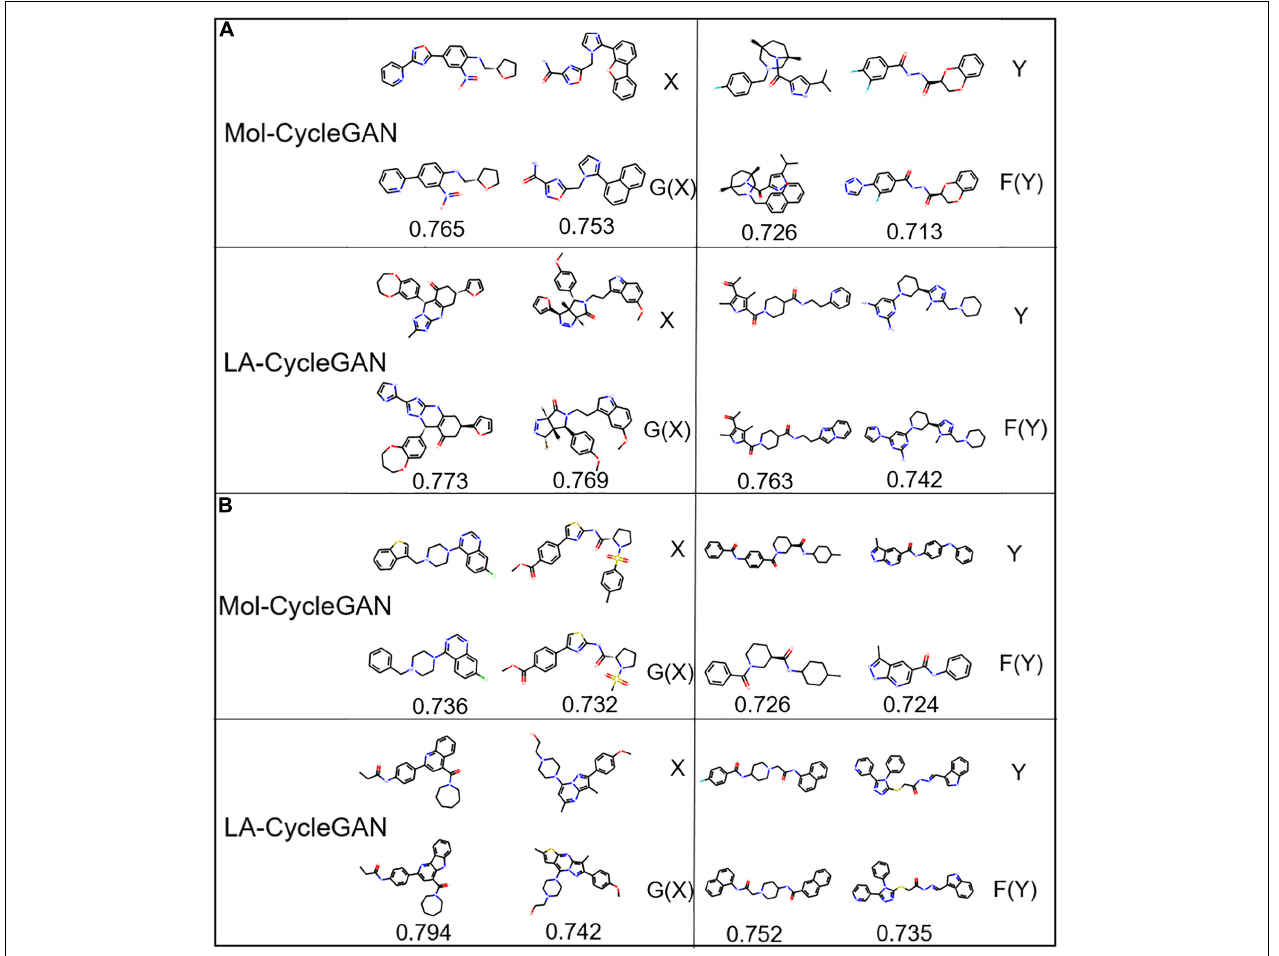
FIGURE 8 | Molecular structure diagram. (A) Molecules from the HBA subset; (B) molecules from HBD subset. In each sub-figure, the upper layer shows the starting molecules, the middle layer shows the generated molecules, and the bottom layer shows the similarity score.